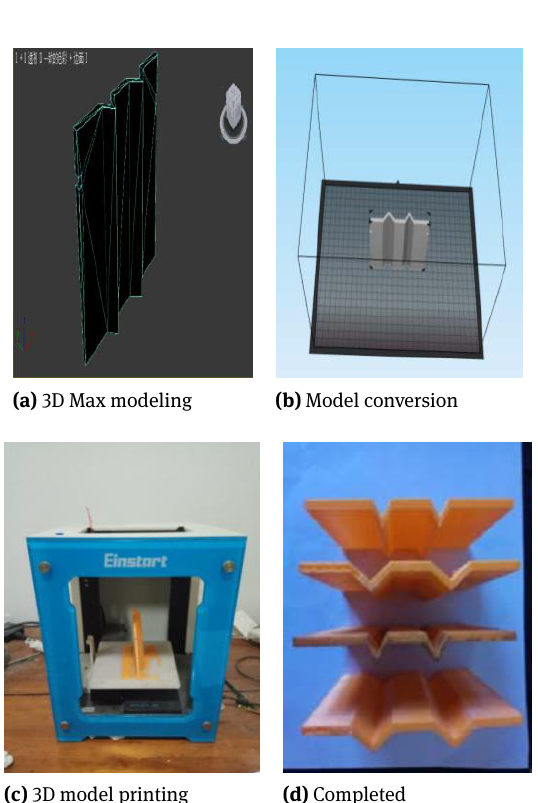
Figure 2: Producing process of 3D printing joint panel